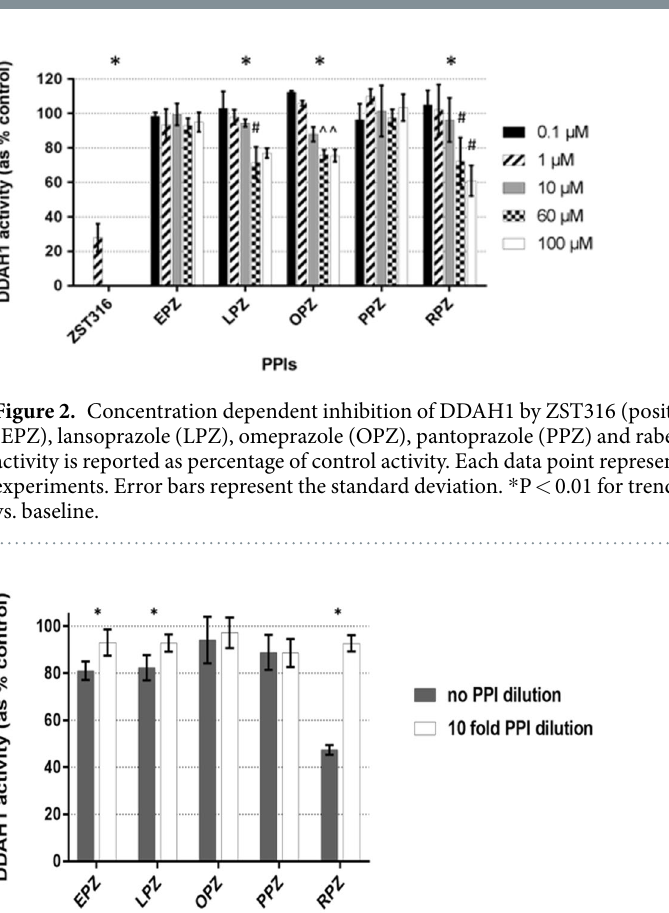
Table 2. Time dependent inhibition of dimethylarginine dimethylaminohydrolase 1 by proton pump inhibitors represented as percent residual activity. Residual dimethylarginine dimethylaminohydrolase 1 activity (expressed as percentage of the control) following different pre-incubation times for each proton pump inhibitor. Each value represents the mean of three experiments ± SD. Experiments were performed with a proton pump inhibitor concentration of 60 µ mol/L. PPI: proton pump inhibitor; * : for trend.